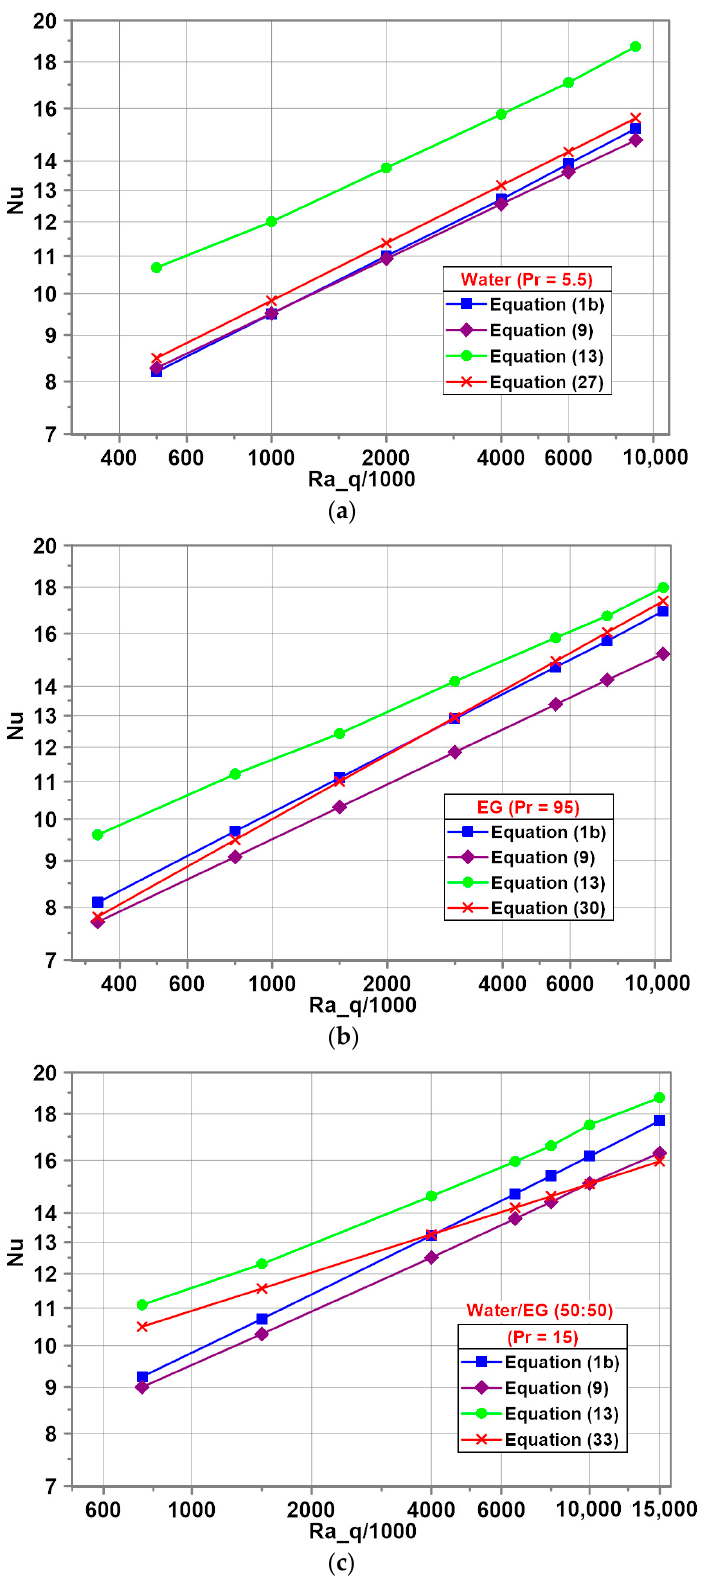
Figure 6. Present Nu-Ra q relationship vs. predictions from literature correlations for water ( a ), EG ( b ), and water-EG (50:50) ( c )